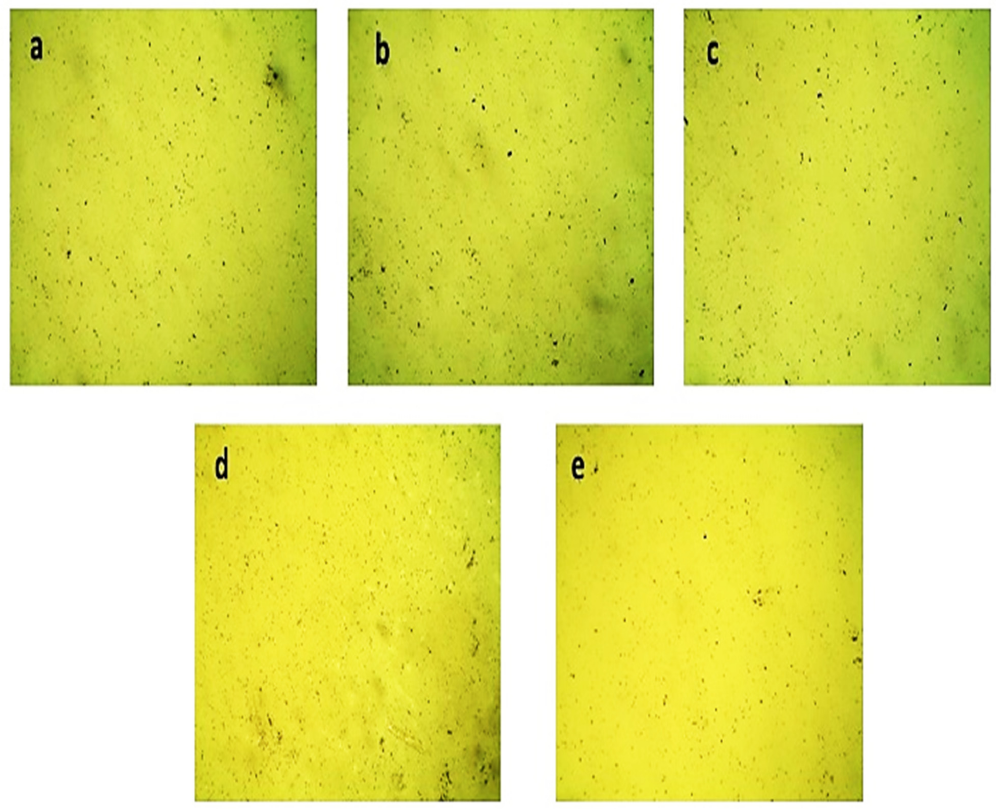
Figure 6. Mg-doped AlSb-deposited thin films’ optical micrographs for time durations of ( a ) 1 h, ( b ) 1.5 h, ( c ) 2 h, ( d ) 2.5 h, and ( e ) 3 h. ( b ) 1.5 h, ( c ) 2 h, ( d ) 2.5 h, and ( e ) 3